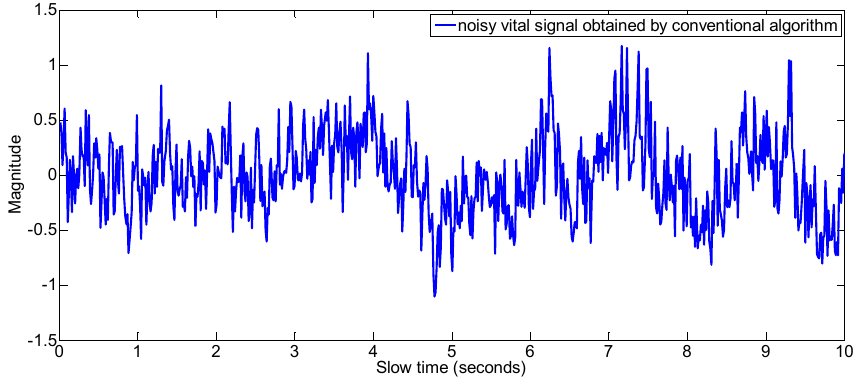
Figure 1. Noisy vital signal obtained by conventional algorithm during motion period.